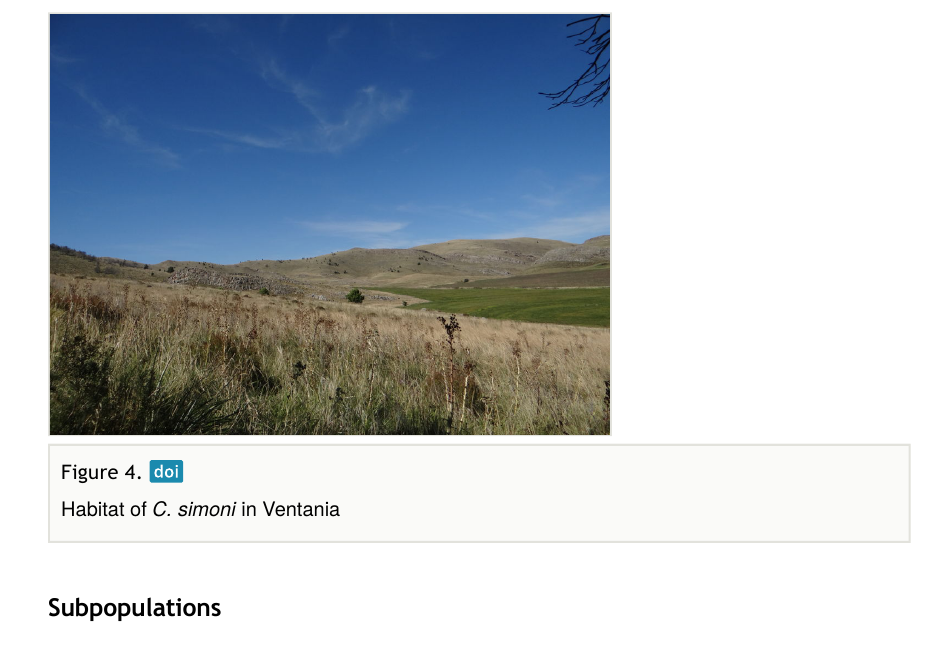
Subpopulations 4 Decline (inferred) Unknown Yes Ferretti et al. (2014a) highlighted the rarity of this species in nature and the speci fi c microclimatic conditions that it needs to survive. A decrease in